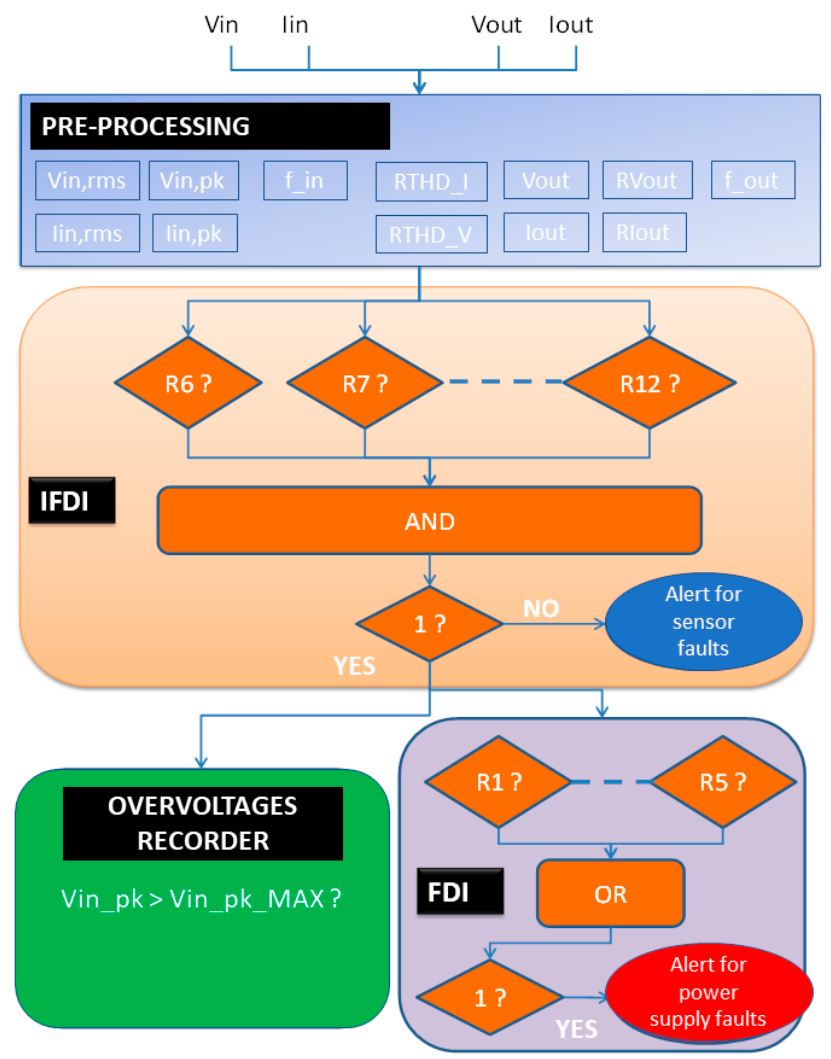
Figure 13. Scheme for the FDI, IFDI, and overvoltages recording.